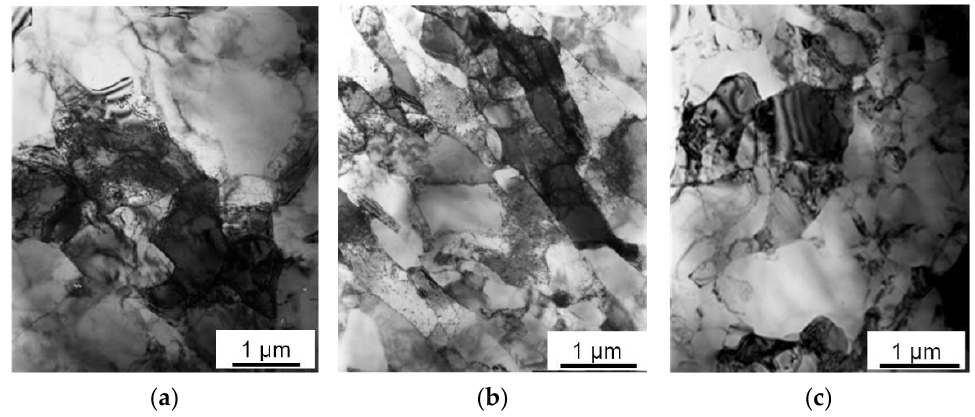
Figure 4. Bright field TEM images of an aluminum matrix in the Al – 30Sn alloy after different number of ECAP passes: ( a ) 1 ECAP ; ( b ) 4 ECAP-A ; ( c ) 4 ECAP-C .